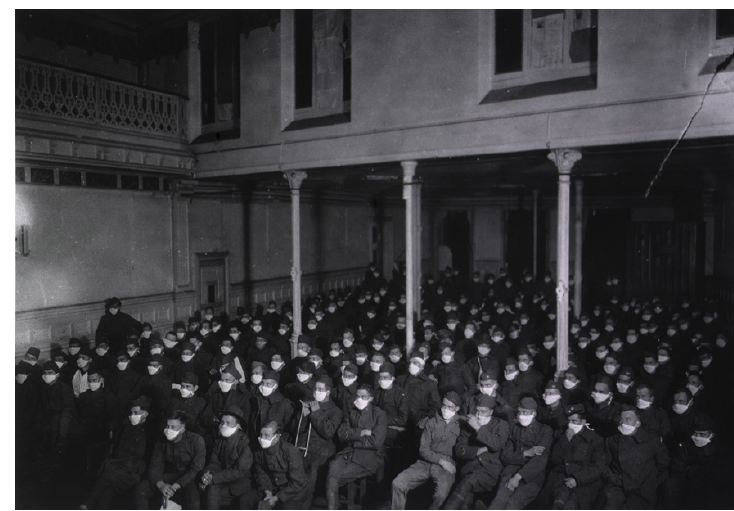
Figure 1 American soldiers in France, masked against influenza, c.1919